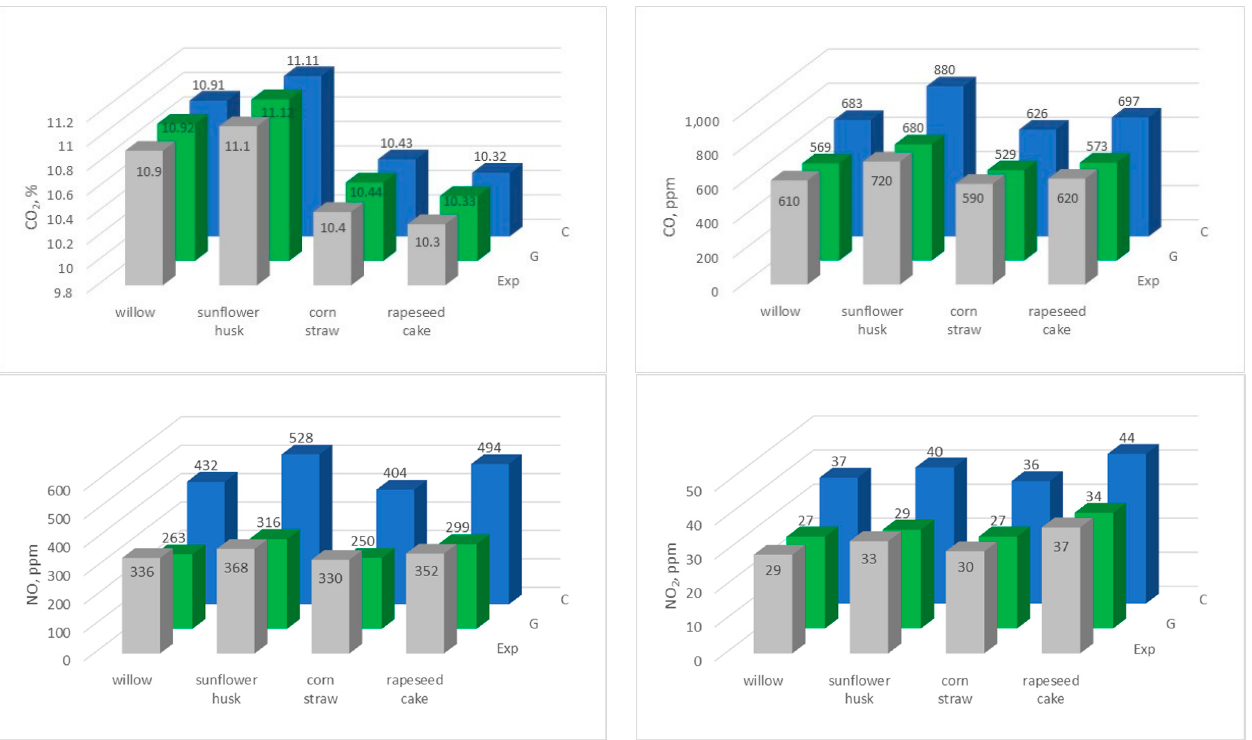
Figure 7. A comparative analysis of the experimental and computational results for the tempera- ture of 600 °C and the residence time of 60 s. of 600 ◦ C and the residence time of 60